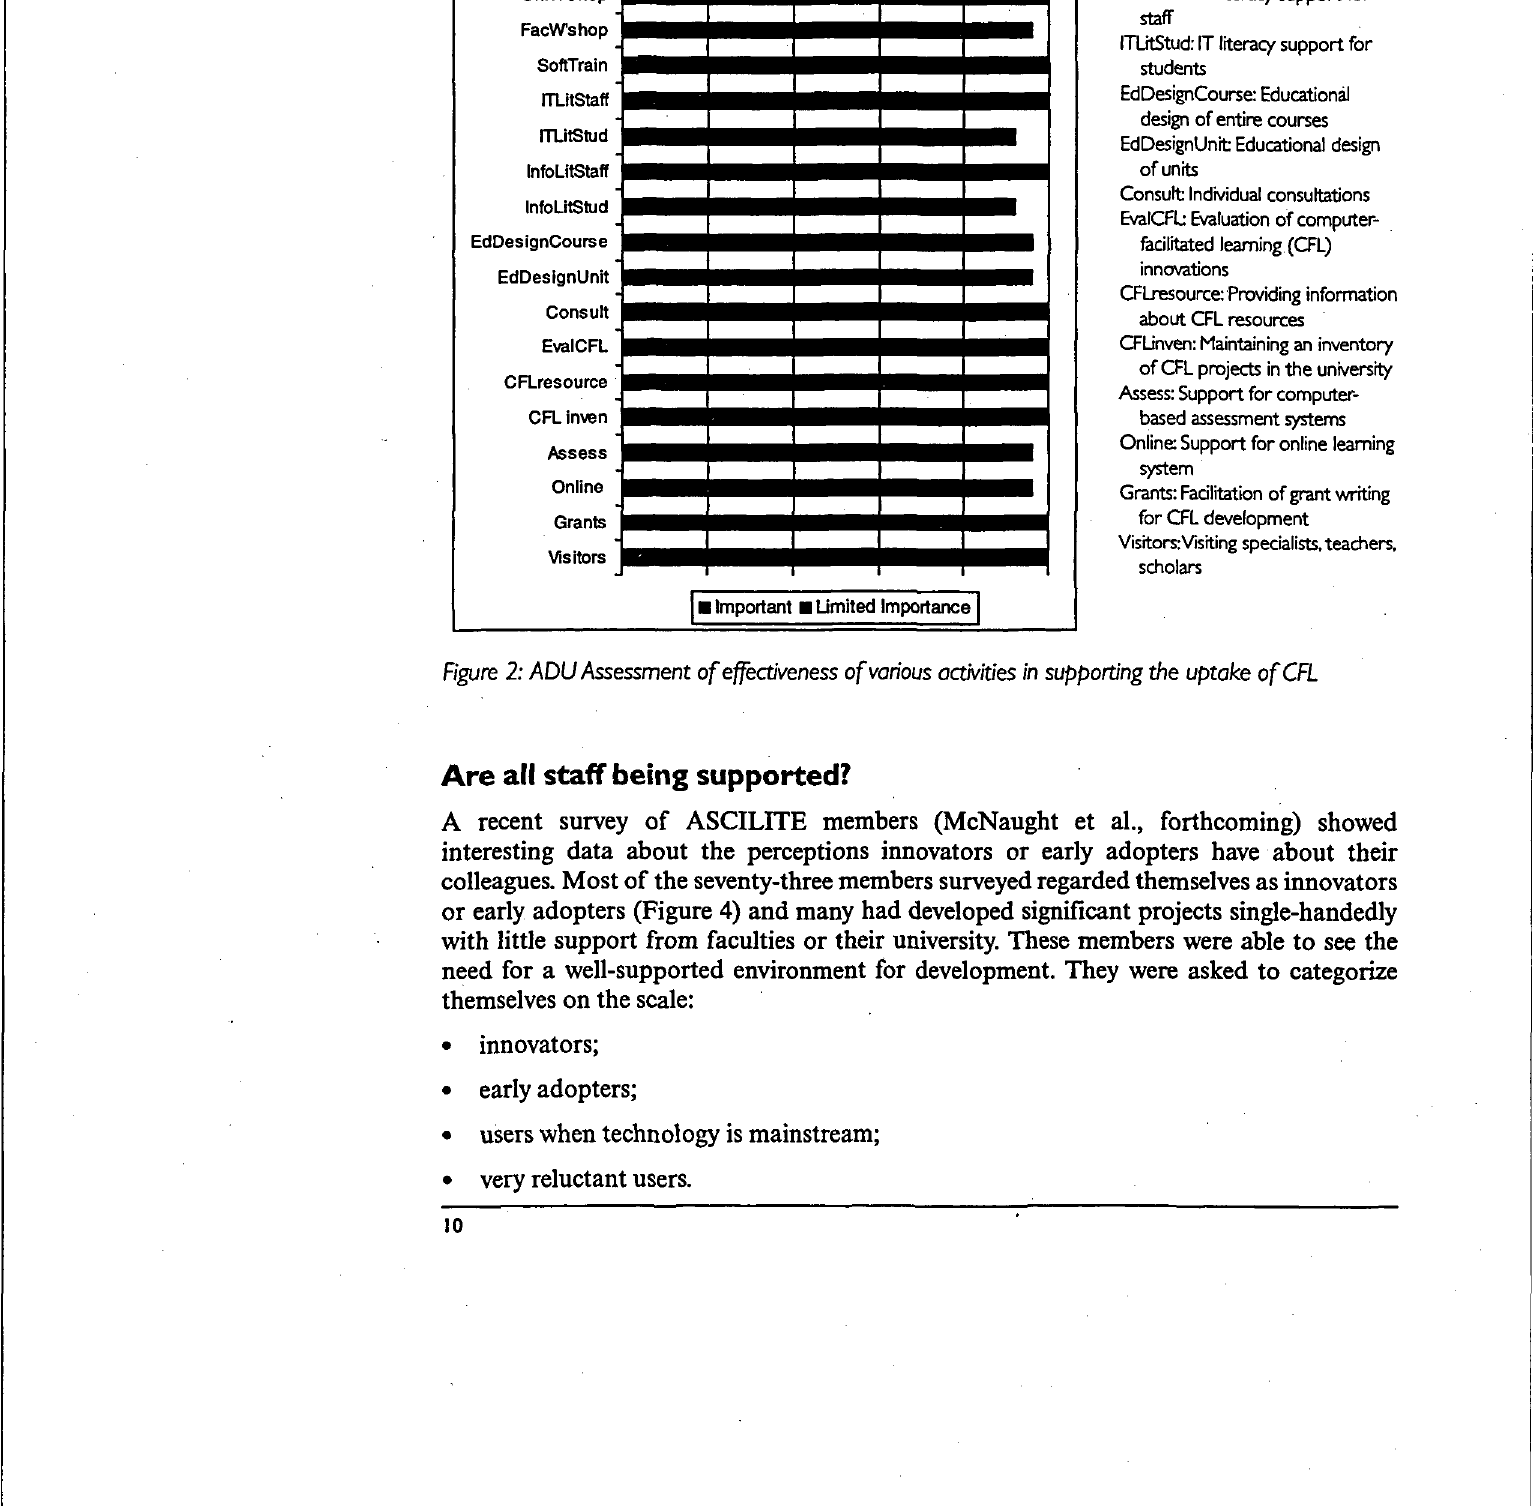
Figure 2: ADU Assessment of effectiveness of various activities in supporting the uptake of CFL